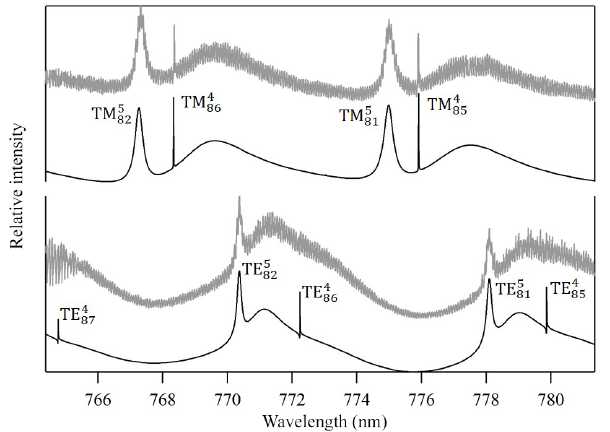
Figure 4. Measured Mie scattering spectra at π/ 2 angle of a lev- itated particle. The positions of the TE and TM resonance modes (e.g., TM l n ; identified by their order ( l ) and mode ( n ) numbers) were used to retrieve the particle’s real refractive index ( n D = 1 . 4665, m 1 = 2745) and size ( a = 9 . 2906µm). We note that the lower-order modes in the fitted TE spectrum are too narrow to be observed in the measured spectrum with the current resolution. Residual noise in the measured spectrum originates mostly from laser power os- cillations due to frequency scanning operation and from horizontal oscillation of the particle due to the applied AC field.